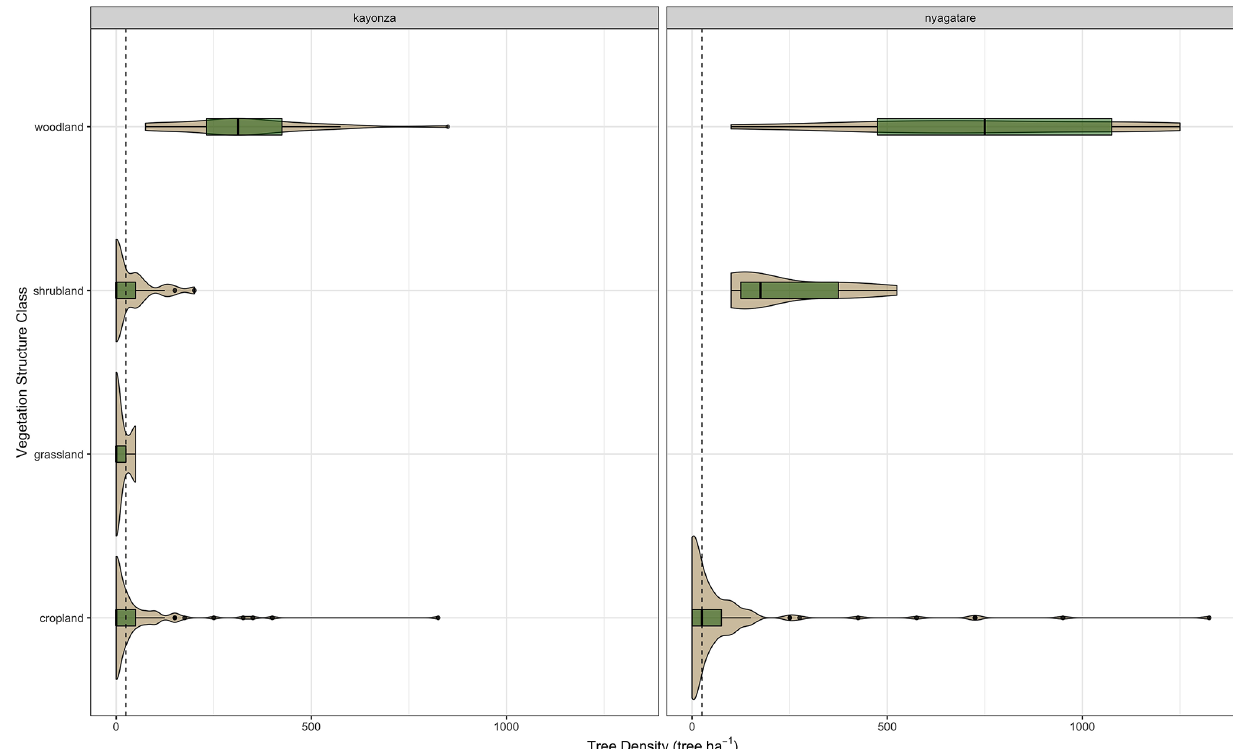
Figure 1. Violin plots showing the variation in tree densities across the vegetation classes at the Kayonza and Nyagatare LDSF sites, Rwanda. The dotted line is the overall median (25treeha − 1